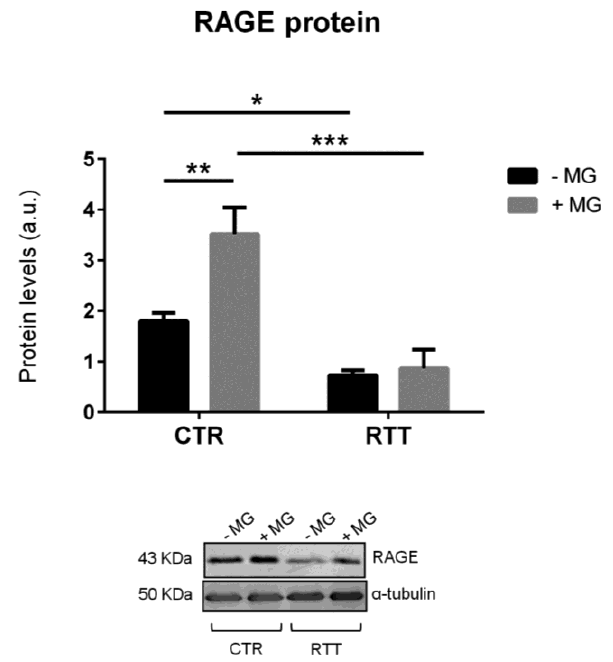
Figure 5. Evaluation of cellular RAGE protein levels in MG-challenged fibroblasts. Data were expressed as means ± SD. Representative (inverted) Western blots were reported. CTR, control; RTT, Rett syndrome; MG, methylglyoxal. * p < 0.05; ** p < 0.01; *** p < 0.001. Results were analyzed by two-way ANOVA, with post hoc Tukey’s multiple comparisons test.